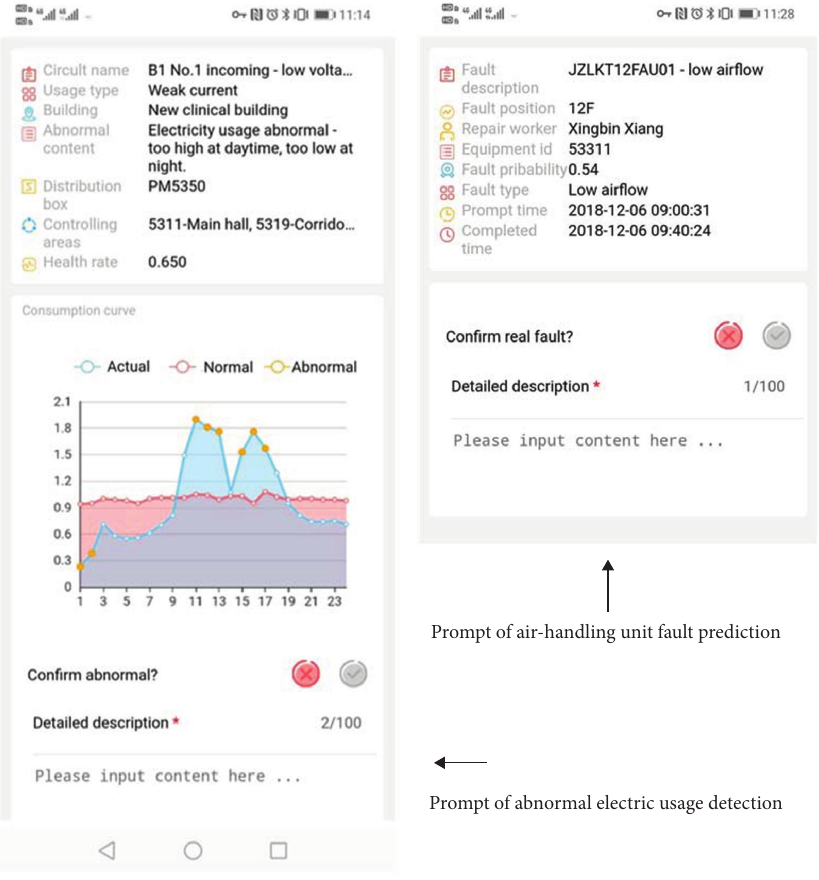
Figure 10: Intelligent diagnosis prompts on mobile